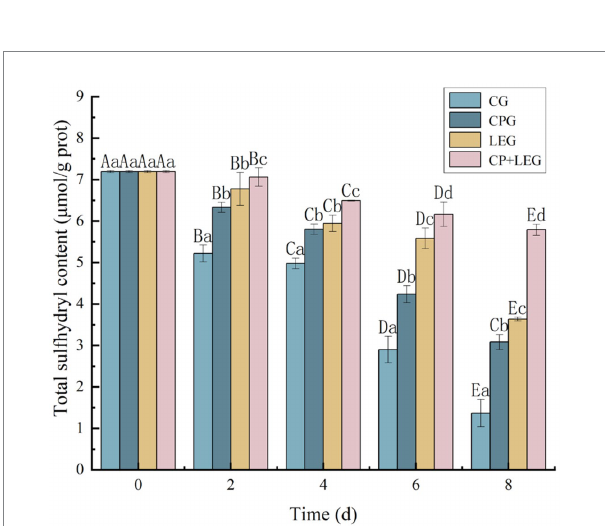
FIGURE 1 The effects of preservation methods on the total sulfhydryl content of mussels. CG, the control group; CPG, the compound preservative group; LEG, the low voltage variable frequency electric field group; CP+LEG, the compound preservative combined with low voltage variable frequency electric field group. At the same storage time, different lowercase letters indicate significant differences between groups; Within the same processing group, different uppercase letters indicate significant differences within the group ( p < 0.05). Data were obtained as the mean ± standard deviation ( n =